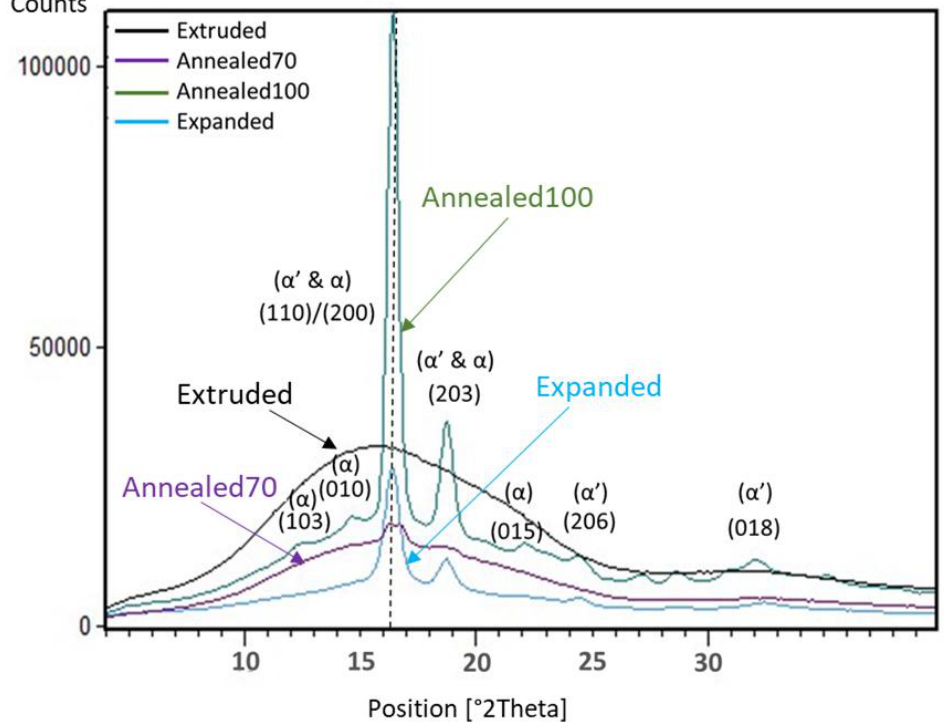
Figure 5. Wide Angle X-Ray Scattering (WAXS) diffractogram overlay of Extruded, Annealed70, Annealed100 and Expanded tubing.